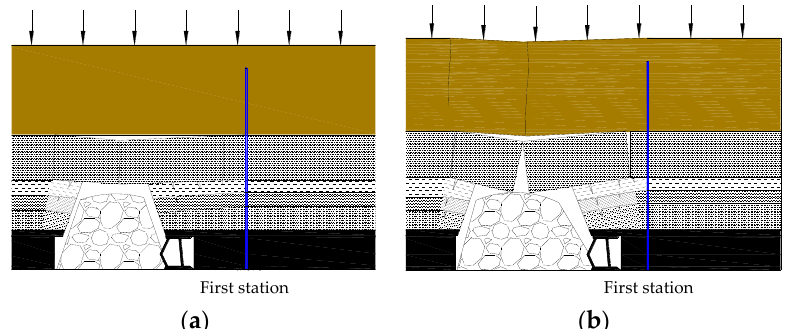
Figure 7. Sketch-profiles of the first caving showing roof structure: ( a ) before the first weighting; ( b ) after the first weighting.